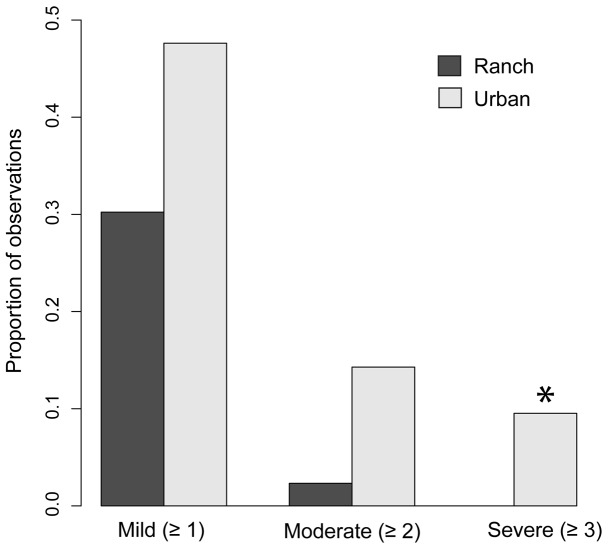
Histological evaluation of testes by site.Testes sectioned from male silversides collected at the ranch site (n = 43) and urban site (n = 42) in 2009 and 2010 were evaluated for necrosis and qualitatively scored on a scale of 1 =  mild, 2 =  moderate, and 3 =  severe. Bars show the proportion of males exhibiting a necrosis rating as bad or worse than the indicated score (≥1, ≥2, or ≥3). Asterisk indicates a significant difference between sites (bias-reduced logistic regression; p<0.05).